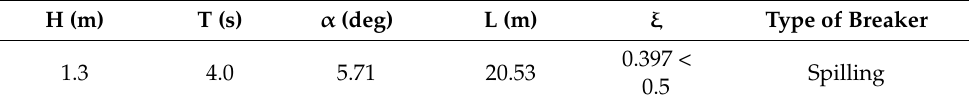
Table 5. Incident wave